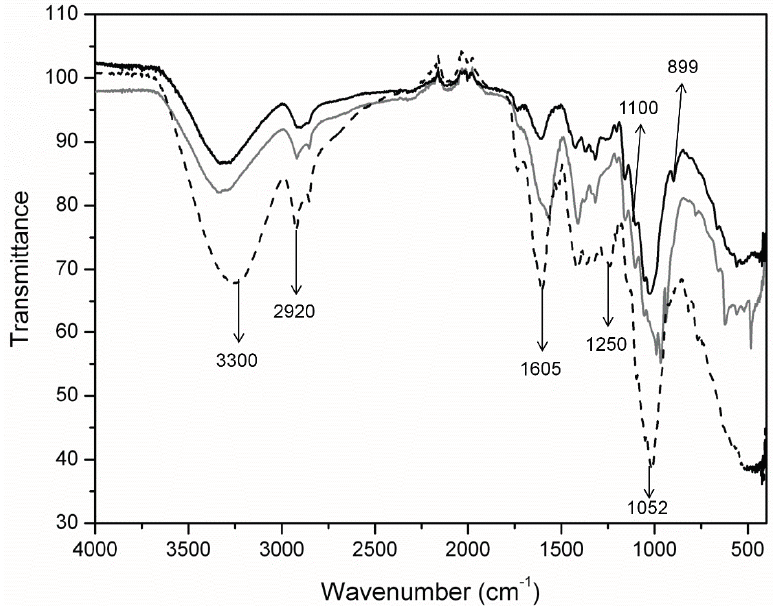
Figure 3. FTIR spectra of: the raw Citrus-waste Biomass (CB) (dashed line), nanocellulose obtained from CB after two-stage procedure of delignification and bleaching (gray), and after an additional enzymatic hydrolysis step